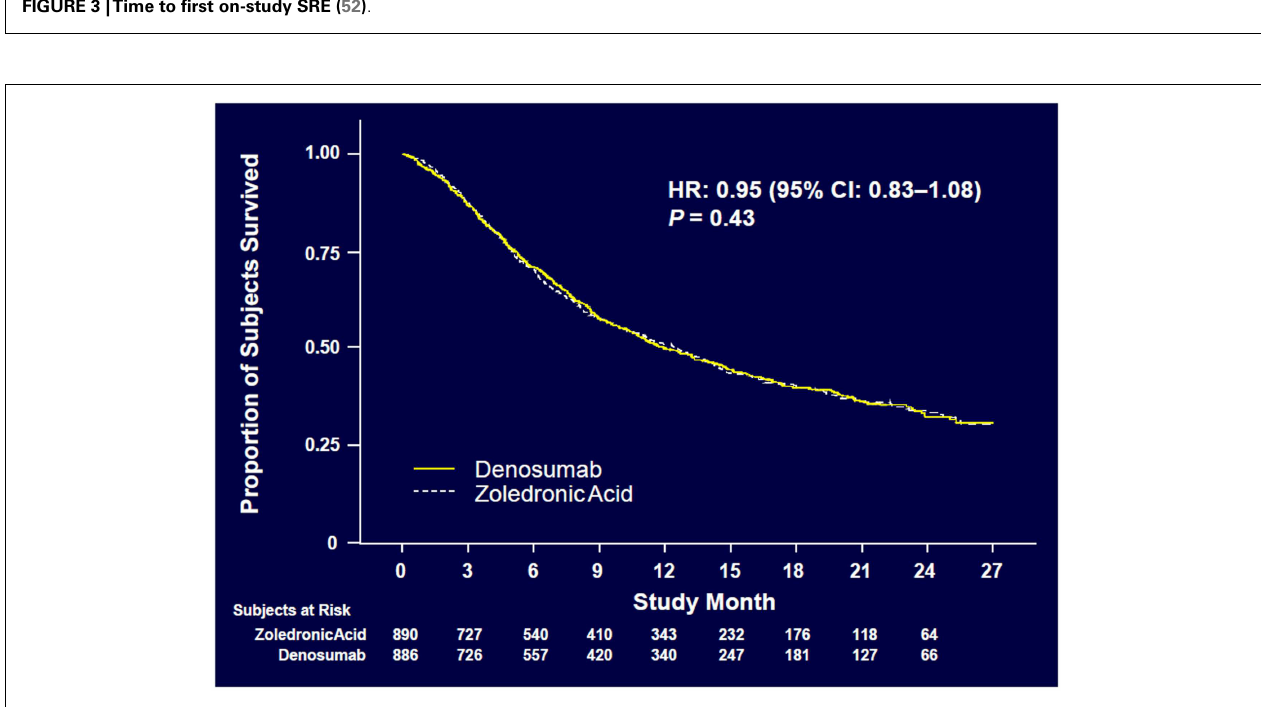
FIGURE 3 |Time to first on-study SRE (52) .